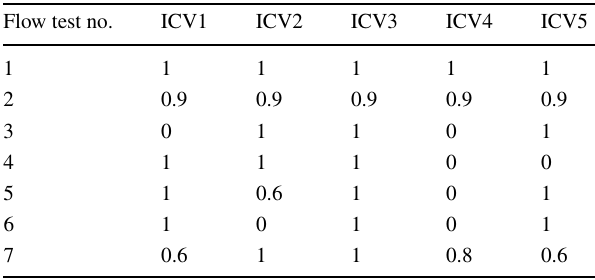
Table 3 ICVs configuration in multi-rate flow tests Flow test